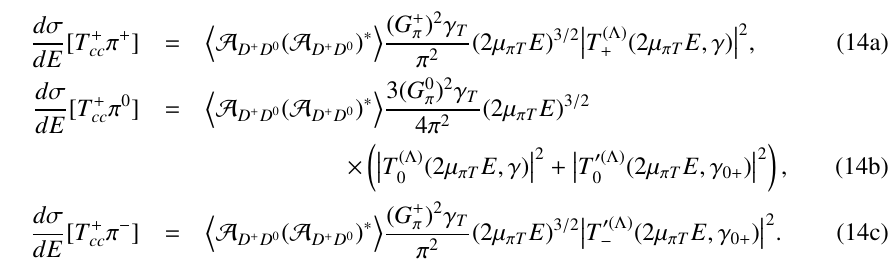
Figure 3. Di ff erential cross sections d σ/ dE from Eqs. (13) as functions of the invariant kinetic energy E for T + blue curves) and for T + curves). The binding energies of T + 320, 360, and 400 keV in order of increasing energy at the peak. The vertical dotted lines are at the limiting triangle-singularity energies E lim scale on the vertical axis is